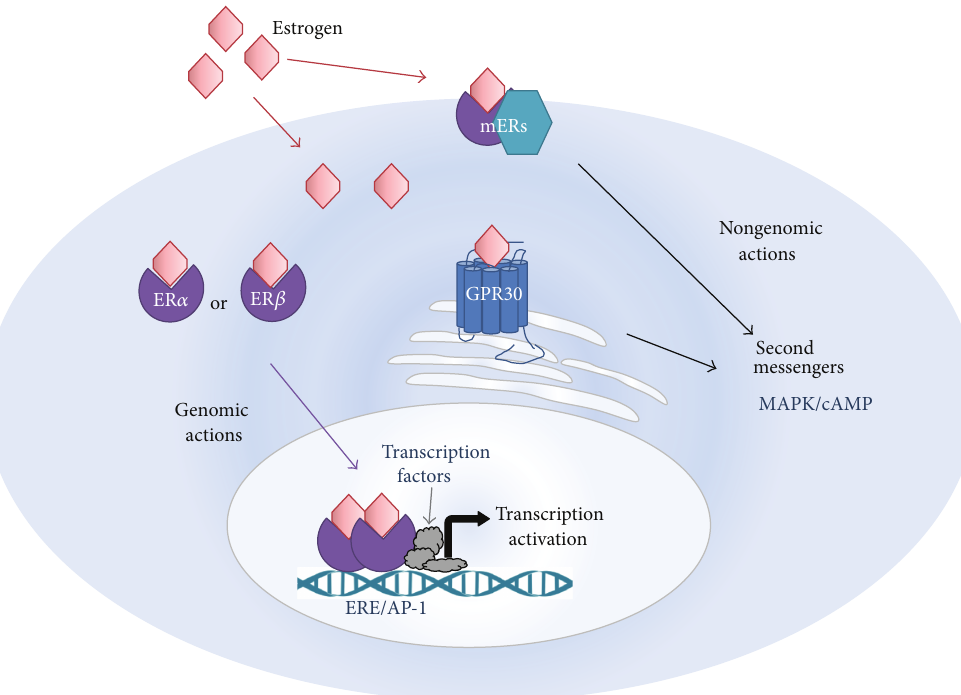
Figure 1: Putative mechanisms of estrogen action in the cell. Estrogen can act via either genomic or nongenomic mechanisms. Genomic mechanisms involve activation of the estrogen receptors (ERs) by estrogen, which then translocate to the cell nucleus as hetero- or homodimers to bind to estrogen response elements (EREs) or to activator protein 1 (AP-1) sites, resulting in transcription activation. Nongenomic actions occur via binding of estrogen to ERs or to a G protein coupled receptor GPR30, either intracellularly or at the plasma membrane (mERs) to activate second messenger systems, such as those involving mitogen-activated protein kinase (MAPK) or cyclic adenosine 3 󸀠 ,5 󸀠 -monophosphate (cAMP) pathways, which can also activate transcription or have other